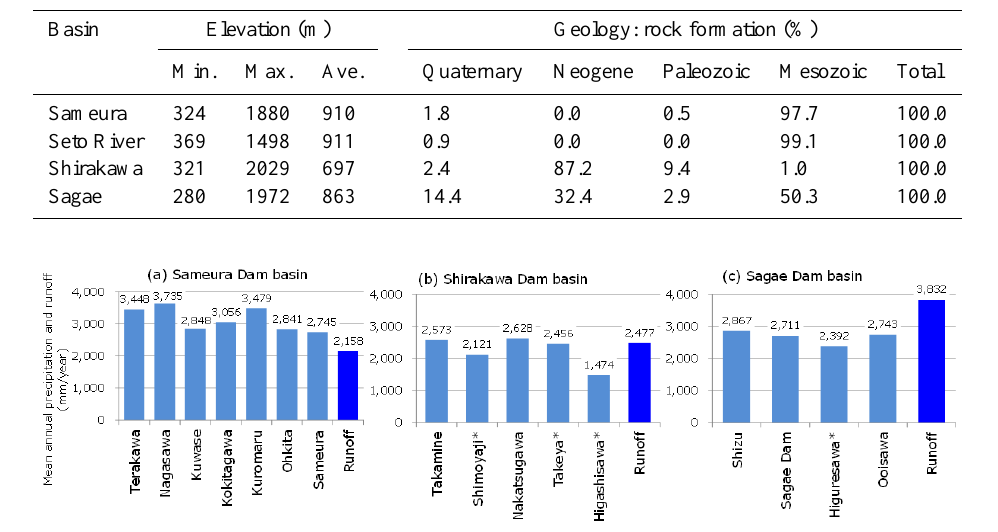
Table 1. Elevations and rock formations of study basins.